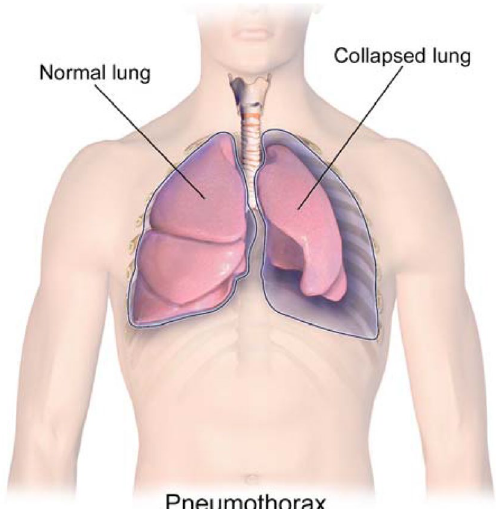
Figure 1. A graphical illustration of pneumothorax. [Medical gallery of Blausen Medical 2014, WikiJournal of Medicine 5